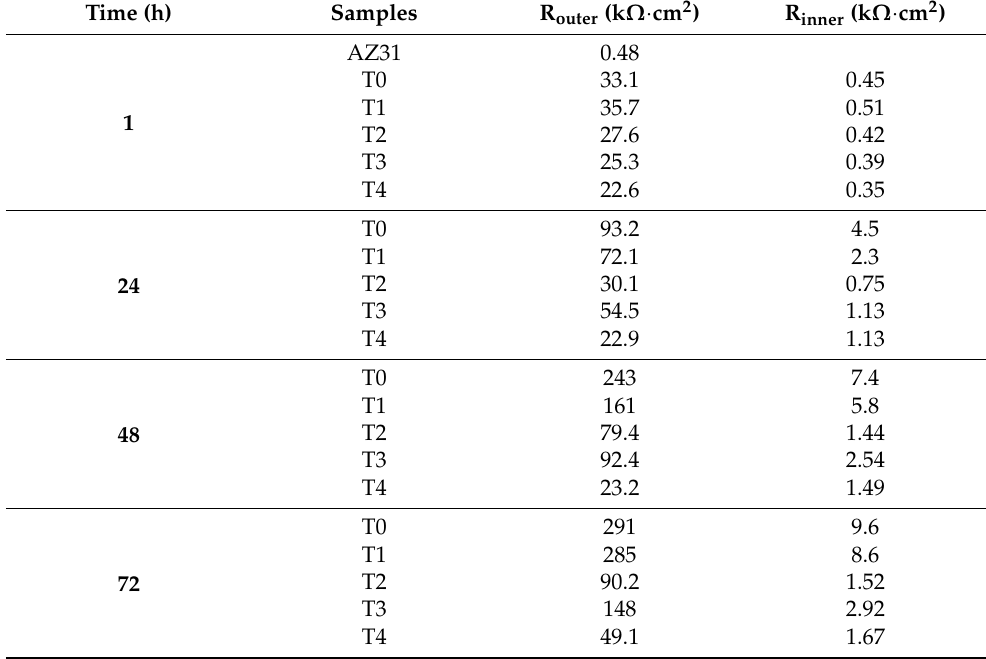
Table 4. Electrochemical data of the uncoated and PEO-coated specimens in SBF solution for various durations, calculated from the circuit